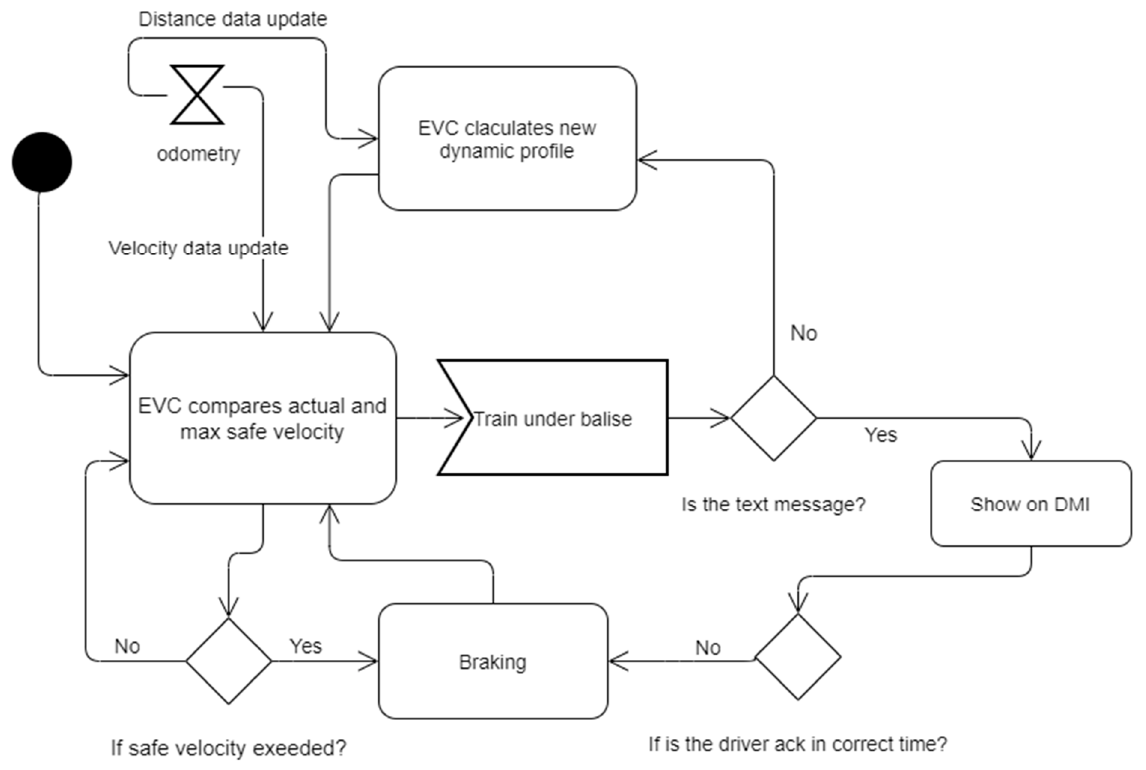
Figure 1. Simpli fi ed diagram of ETCS system operation. Figure 1. Simplified diagram of ETCS system